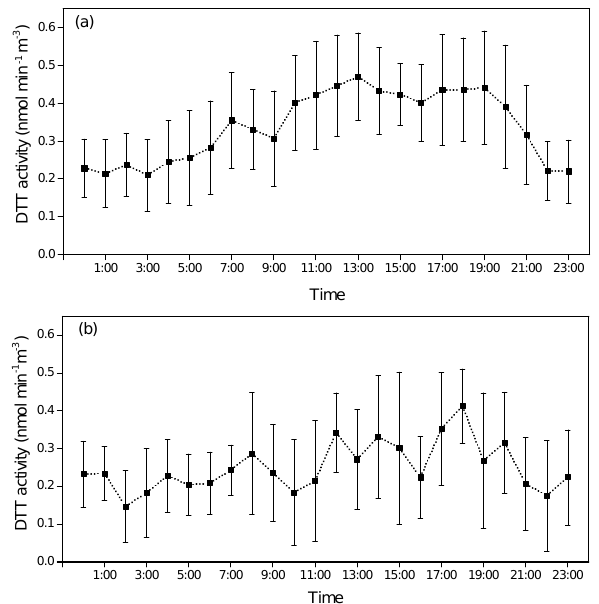
Figure 4. Diurnal profile of the ambient PM 2 . 5 DTT activity mea- sured at the sampling site over (a) weekdays ( n = 18 days) and (b) weekends ( n = 10 days). The data from 31 May to 2 July 2017 were used for plotting this profile. Error bars are the standard devi- ation (1 σ) of the average DTT activity in that